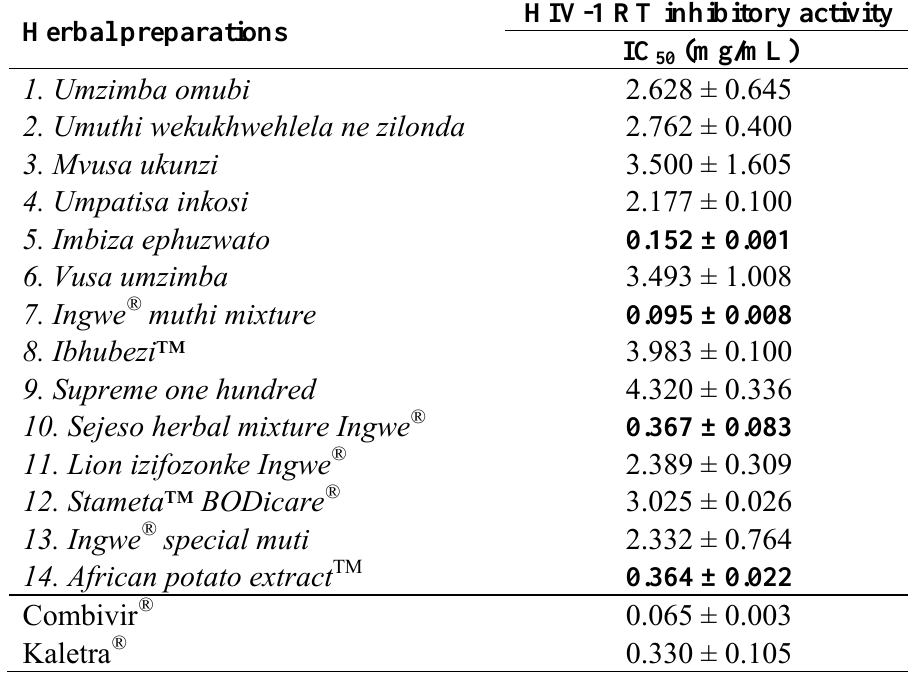
mg/mL) of fourteen herbal preparations sold in 50